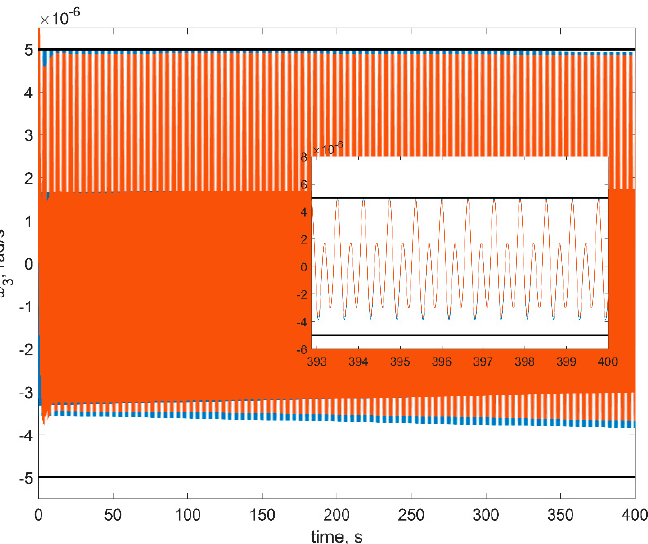
Figure 8. Evolution of ω 3 (red is numerical solution, blue is approximate solution, horizontal lines are the estimations).